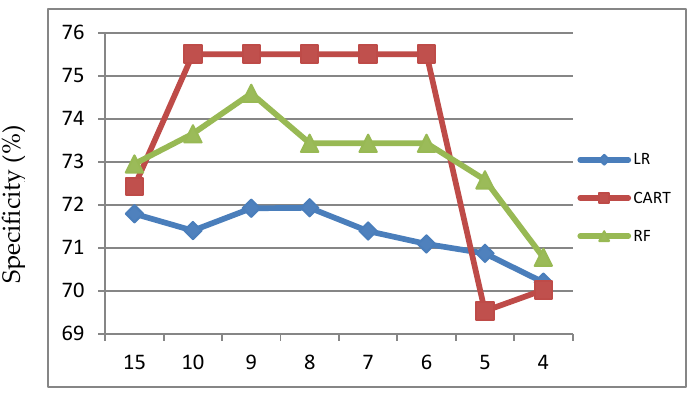
Figure 5. Sensitivity of LR, CART and RF with input of important variables identified by CART.